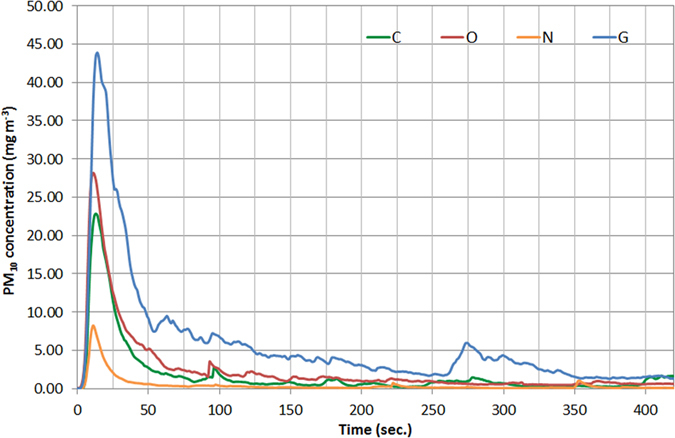
PM10 concentrations measured in the aeolian simulations in the experimental plots (Nn-natural, Gn-grazing, Cn- cultivation, On- organic) under wind velocity of ~7 m s−1.The results were used to calculate PM10 fluxes from the topsoil (mg m−2 min−1) (Table 2).